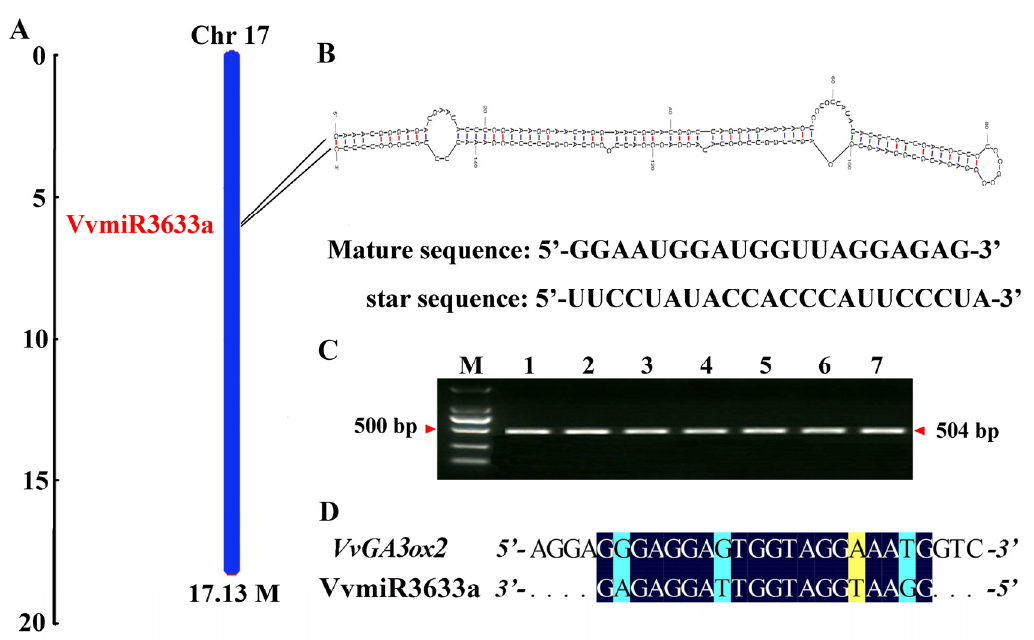
Figure 2. Identification of microRNA3633a and its target genes. Chromosomal location of VvmiR3633a ( A ); The stem-loop structure of pre-VvmiR3633a and its mature sequence and star sequences ( B ); Cloning of VvMIR3633a gene ( C ); The interaction pattern and mismatch rate of VvmiR3633a and its VvGA3ox2 target genes ( D